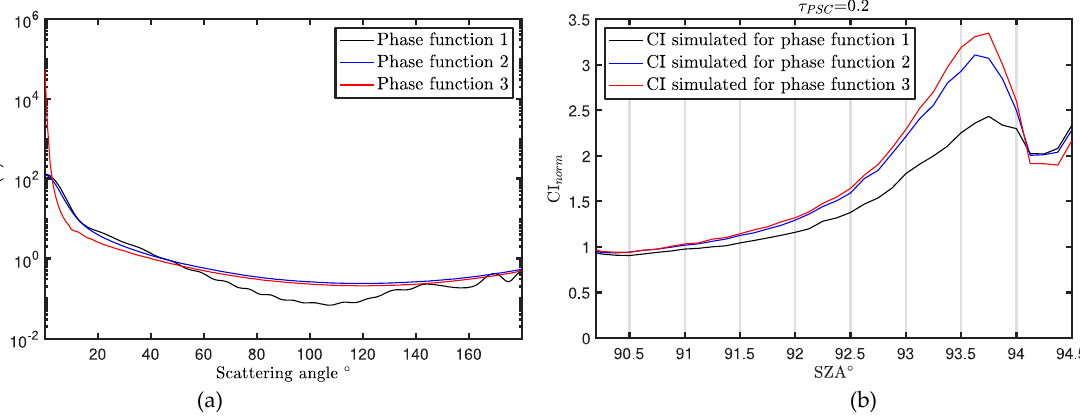
Figure 3. ( a ) Cloud phase functions computed using T-Matrix for different r eff values and; ( b ) Sim- ulated color index during twilight for the phase functions illustrated in previous panel and for h PSC = 22 km and τ PSC = 0.2.